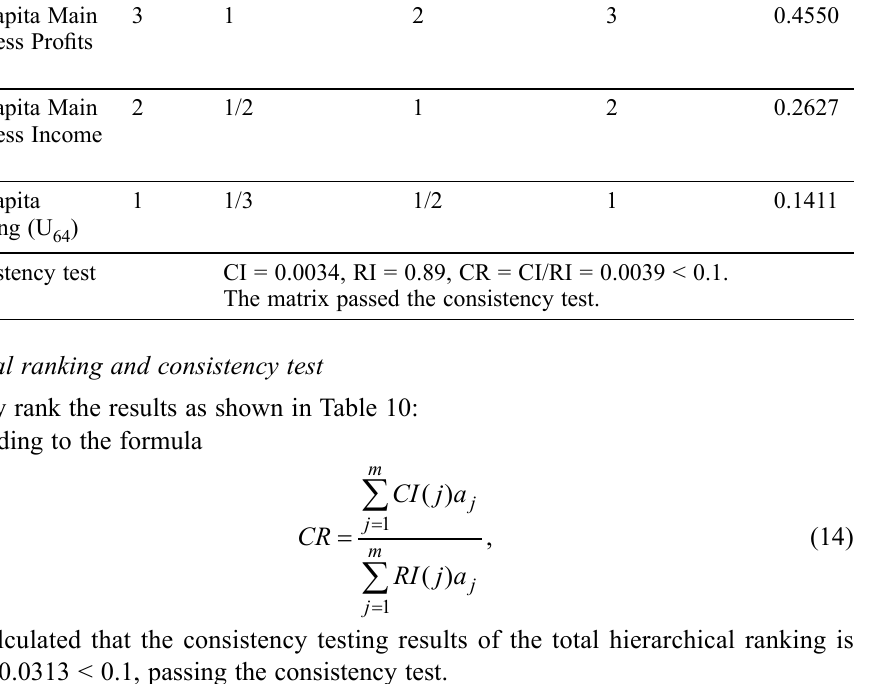
Table 9. Judgment matrix and relative data of U